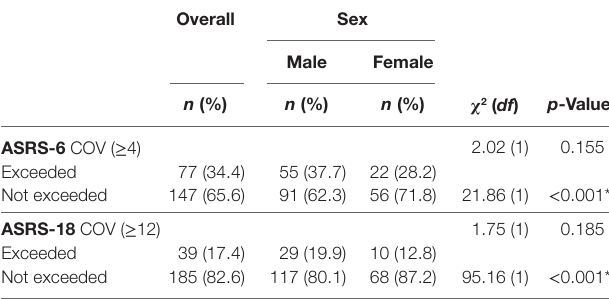
TaBle 2 | ASRS-v1.1 COVs of the overall sample ( N = 224) and separated by